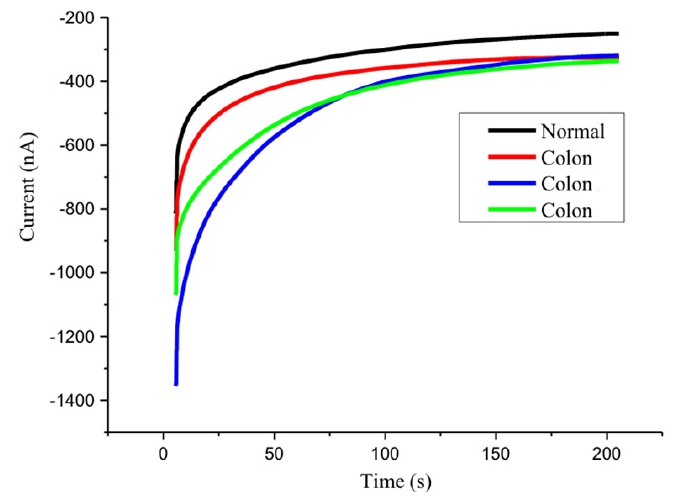
Figure 2. Stability triple testing of the miR-21 biosensor using a single colorectal cancer patient and normal urine sample, recorded with chronoamperometry.